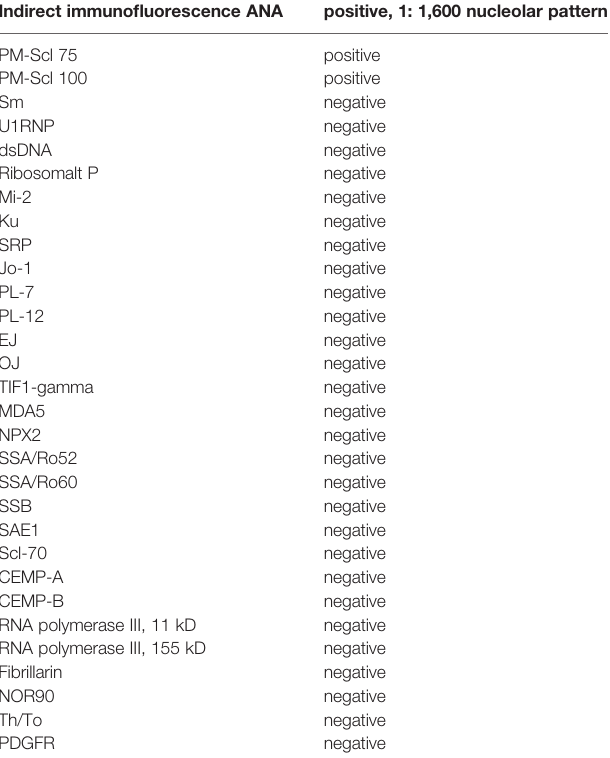
TABLE 1 | Autoantibodies.